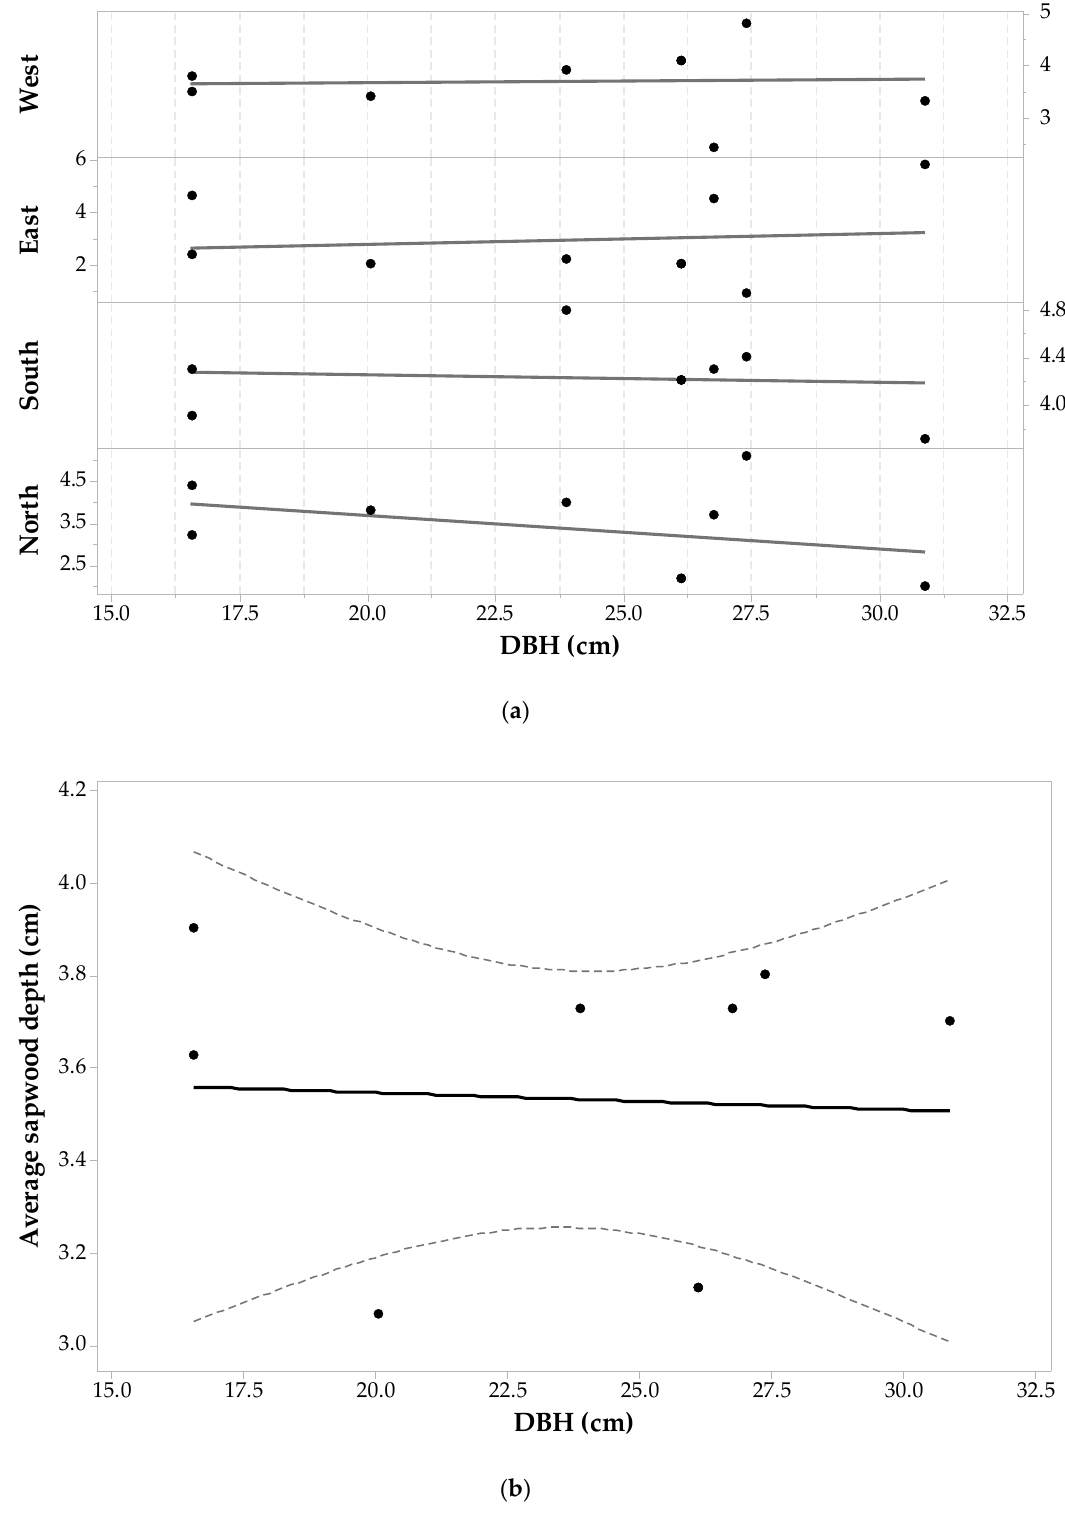
Figure 5. Pinus contorta ( a ) sapwood depth (cm) at each cardinal point for each tree versus DBH ; and ( b ) average sapwood depth (points) with 95% confidence intervals (dashed lines) and a fitted linear regression model (solid line).